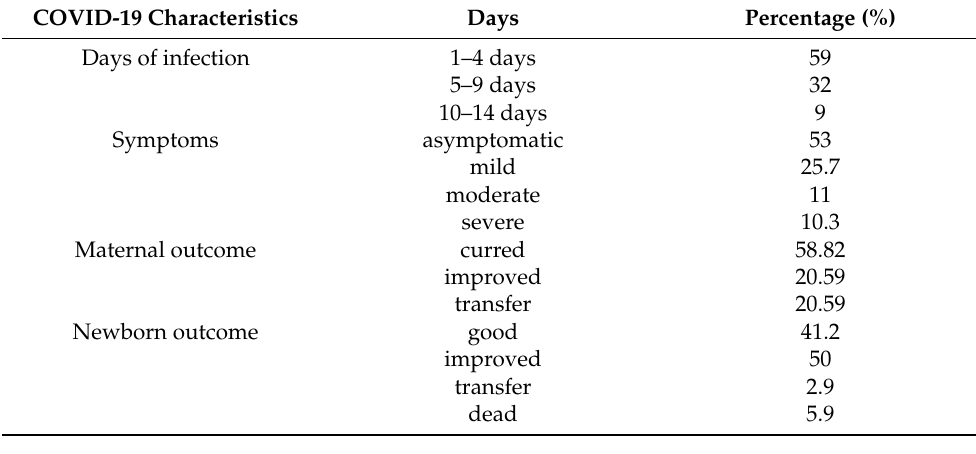
Table 3. COVID-19-related characteristics in the study group.